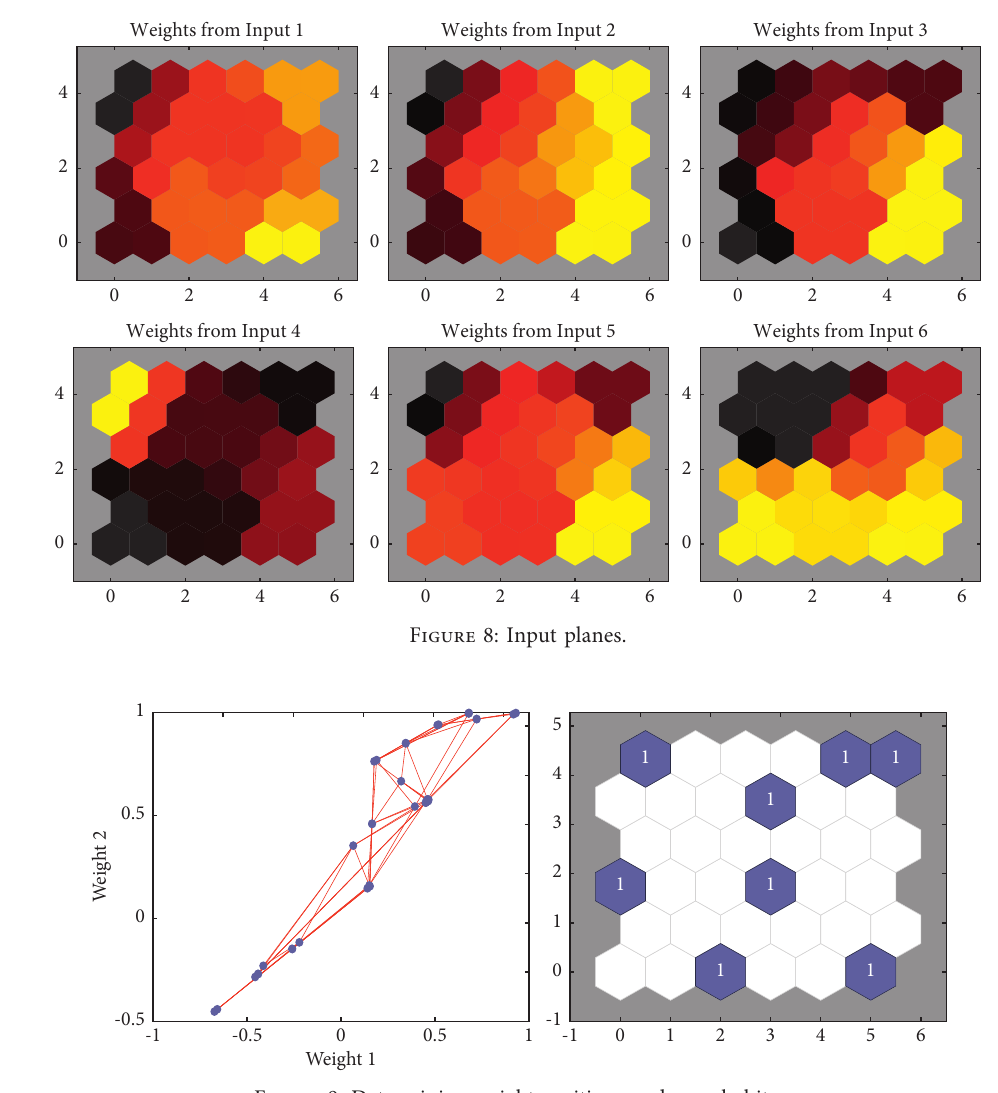
Figure 9: Data mining weight positions and sample hits.